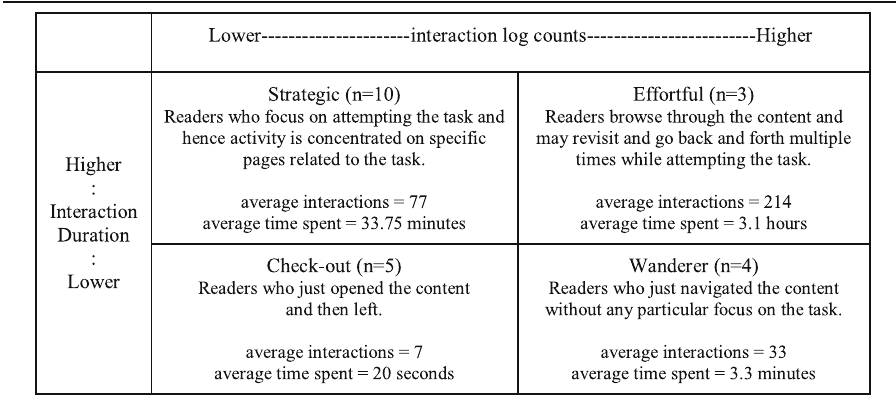
Table 2 Distribution of profiles of readers during the learning activity